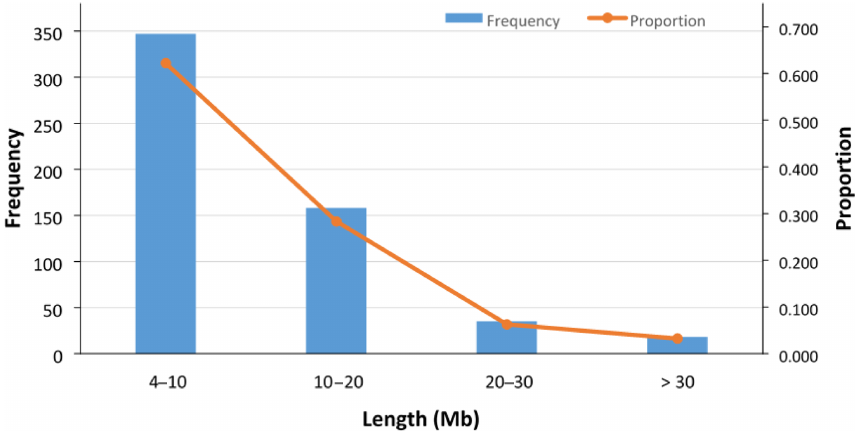
Figure 3. Frequency and proportion of detected ROHs with different lengths (Mb). In total, 558 ROHs (with average length of 10 . 77 ± 8 . 36Mb) were detected in 89 sheep, and in 7 remaining sheep no ROHs were found. The ROH segments with the length of 4–10Mb were the most frequent (62.2%), and those with the length of > 30Mb were the least frequent (3.2%).